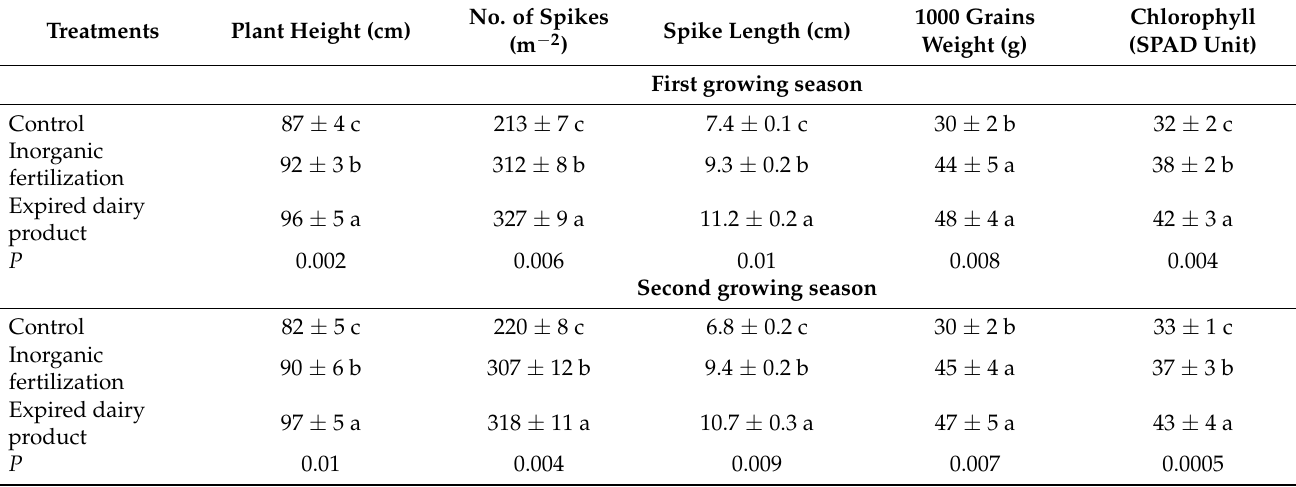
Table 2. Effect of organic and inorganic fertilization wheat growth and yield attributes.